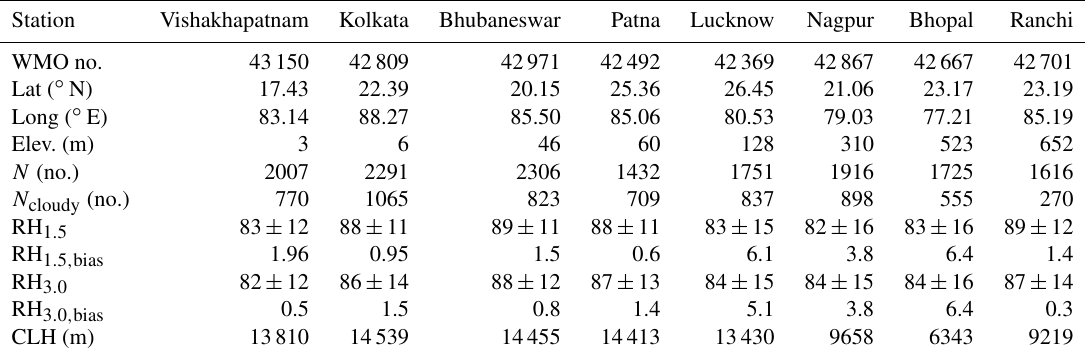
Table 2. World Meteorological Organization (WMO) index number of radiosonde stations (WMO no.), station latitude (lat), longitude (long), elevation above mean sea level (elev.), number of radiosonde profiles ( N ), number of cloudy profiles ( N cloudy ) , mean RH (relative humidity), and bias in RH for 1.5km layer (RH 1 . 5 and RH 1 . 5 , bias , respectively.) and 3.0km layer (RH 3 . 0 and RH 3 . 0 , bias , respectively), and median of cloud layer height (CLH) for each of the eight radiosonde stations used in the humidification analysis. The symbol “ ± ” indicates standard deviation.